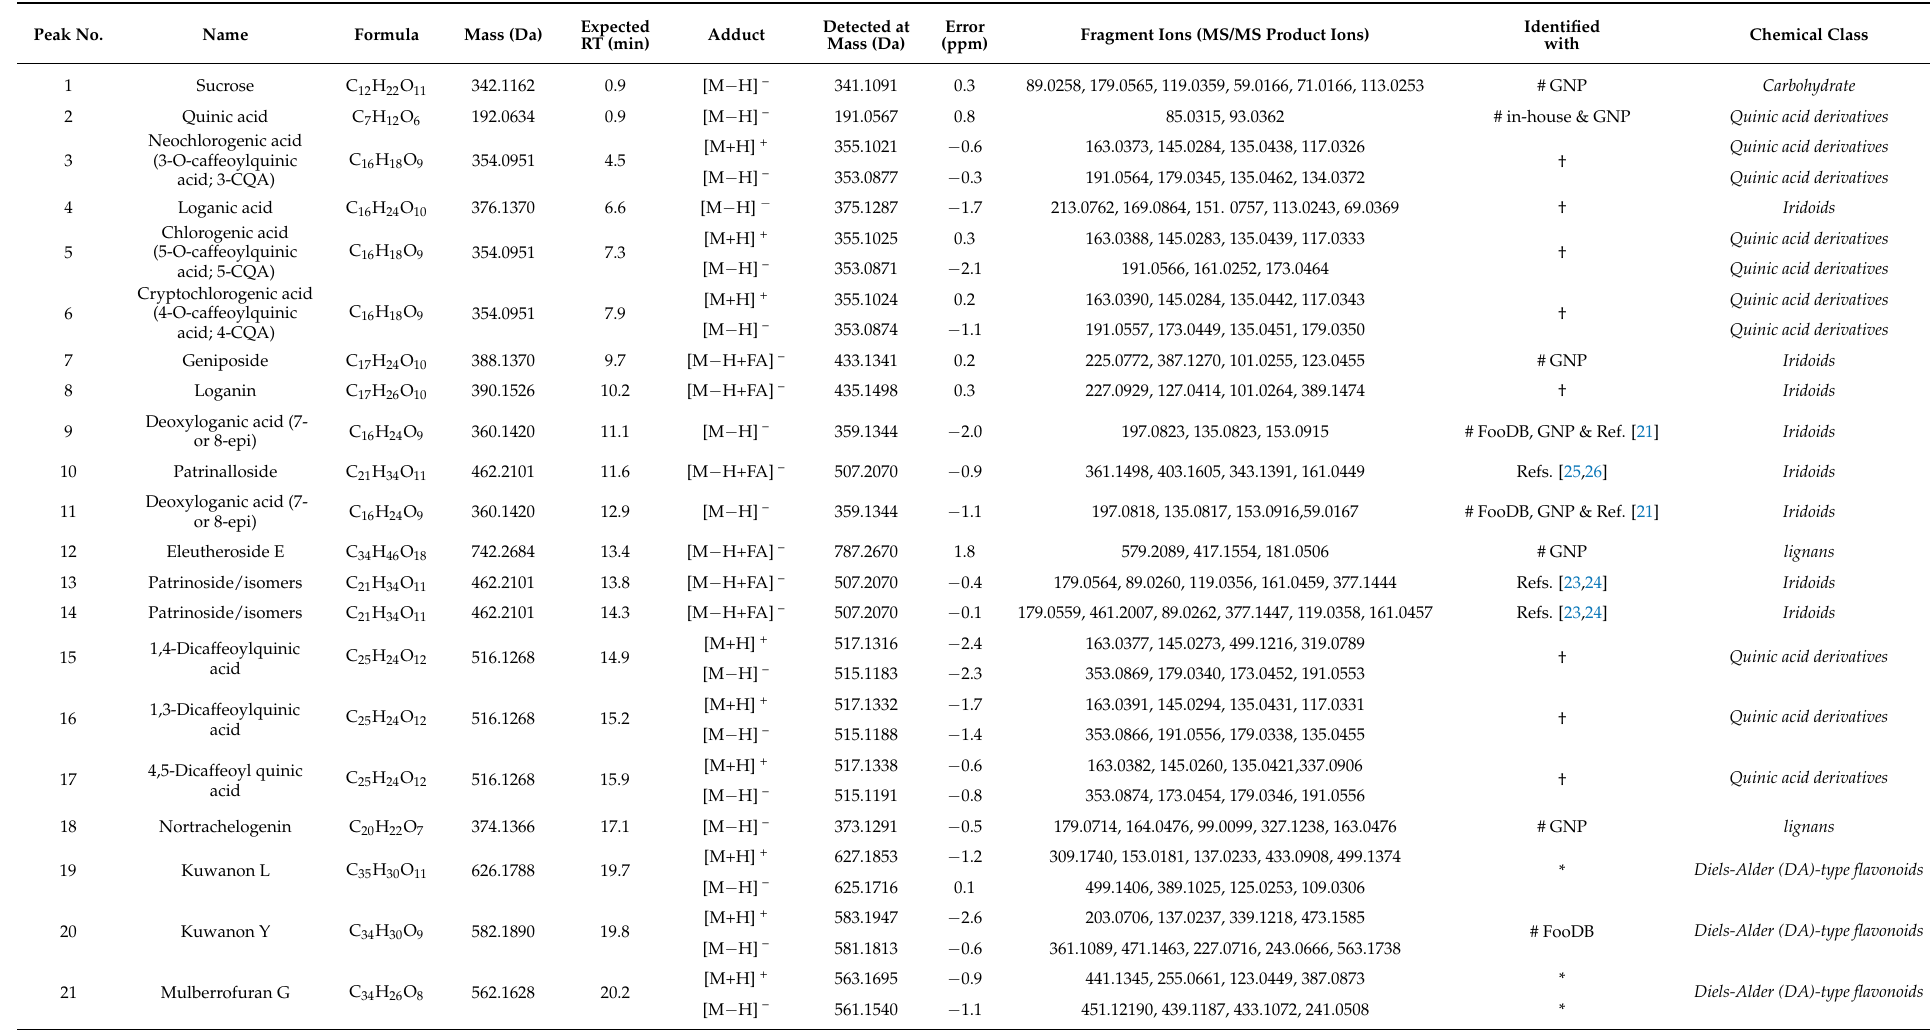
Table 1. Identification of chemical components in PSY using LC-ESI-QTOF